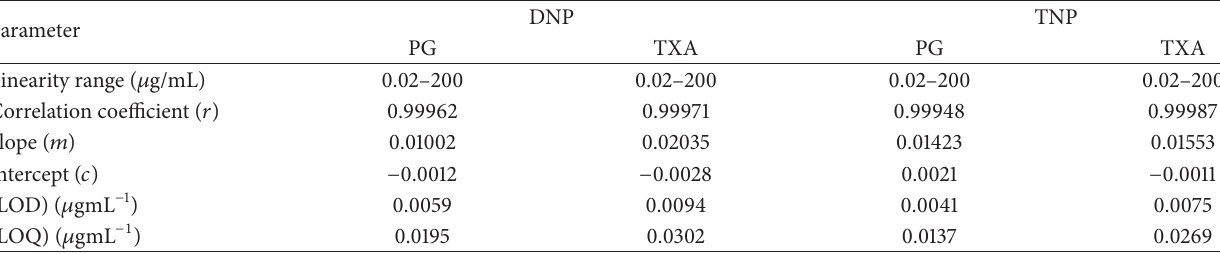
Table 2: Linearity and range.